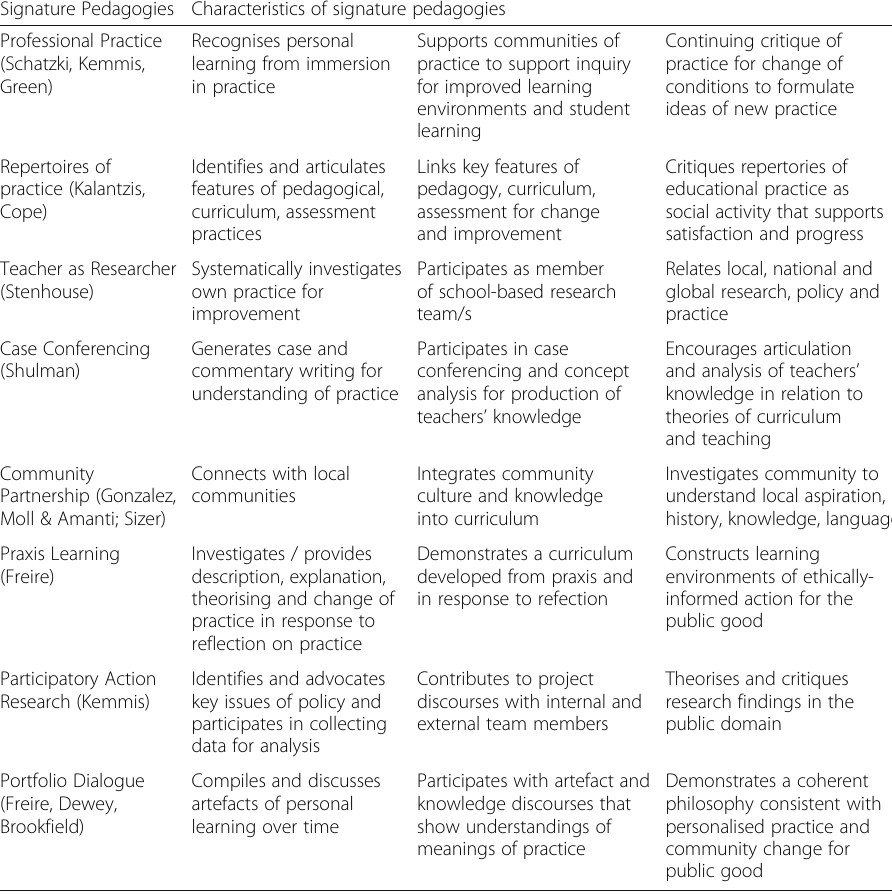
Table 1 Signature Pedagogies Signature Pedagogies Characteristics of signature